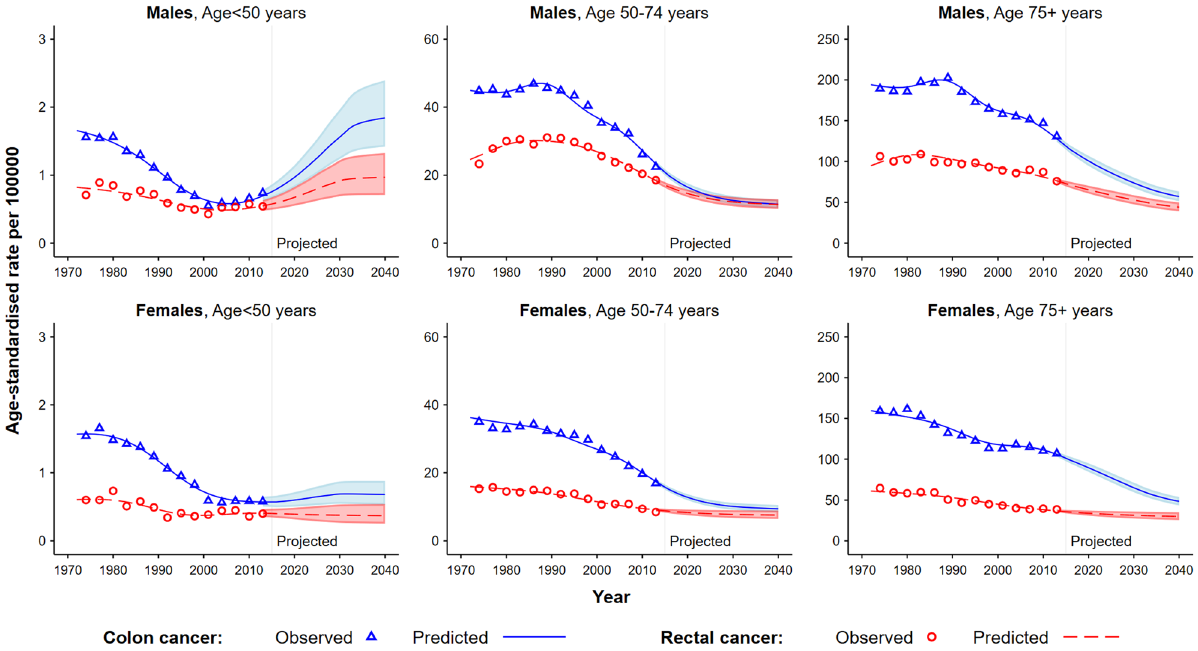
Figure 3. Observed and predicted age-standardised mortality rates for colon and rectal cancers by sex and age group in Australia, 1972–2040. Observed and predicted mortality rates were based on the data from the New South Wales Cancer Registry. All rates are age-standardised using the Segi World standard population. The shaded area represents the 95% uncertainty interval.